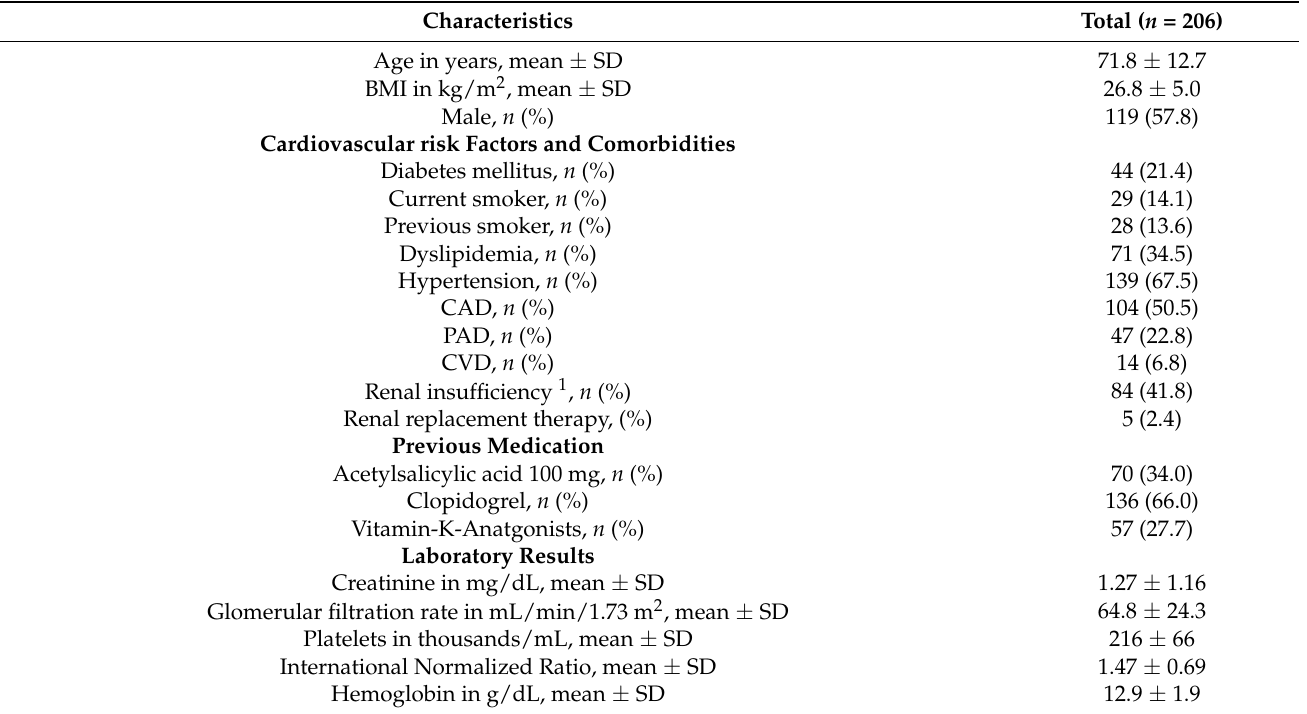
Table 2. Baseline characteristics of patients with access site complications proven by duplex